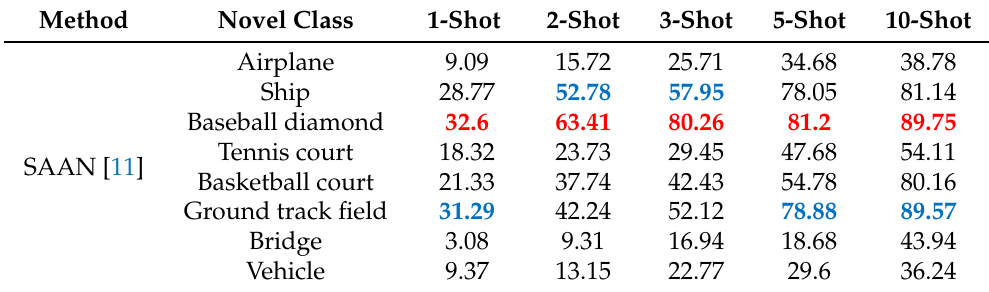
Table 4. FSOD performance (AP50 in %) on the novel classes of the NWPU VHR-10 dataset . Random 1 class is chosen to be the novel one, keeping the rest classes as base ones. Red and blue indicate the 1st and 2nd highest accuracy, respectively. SAAN is a meta learning-based few-shot detector.